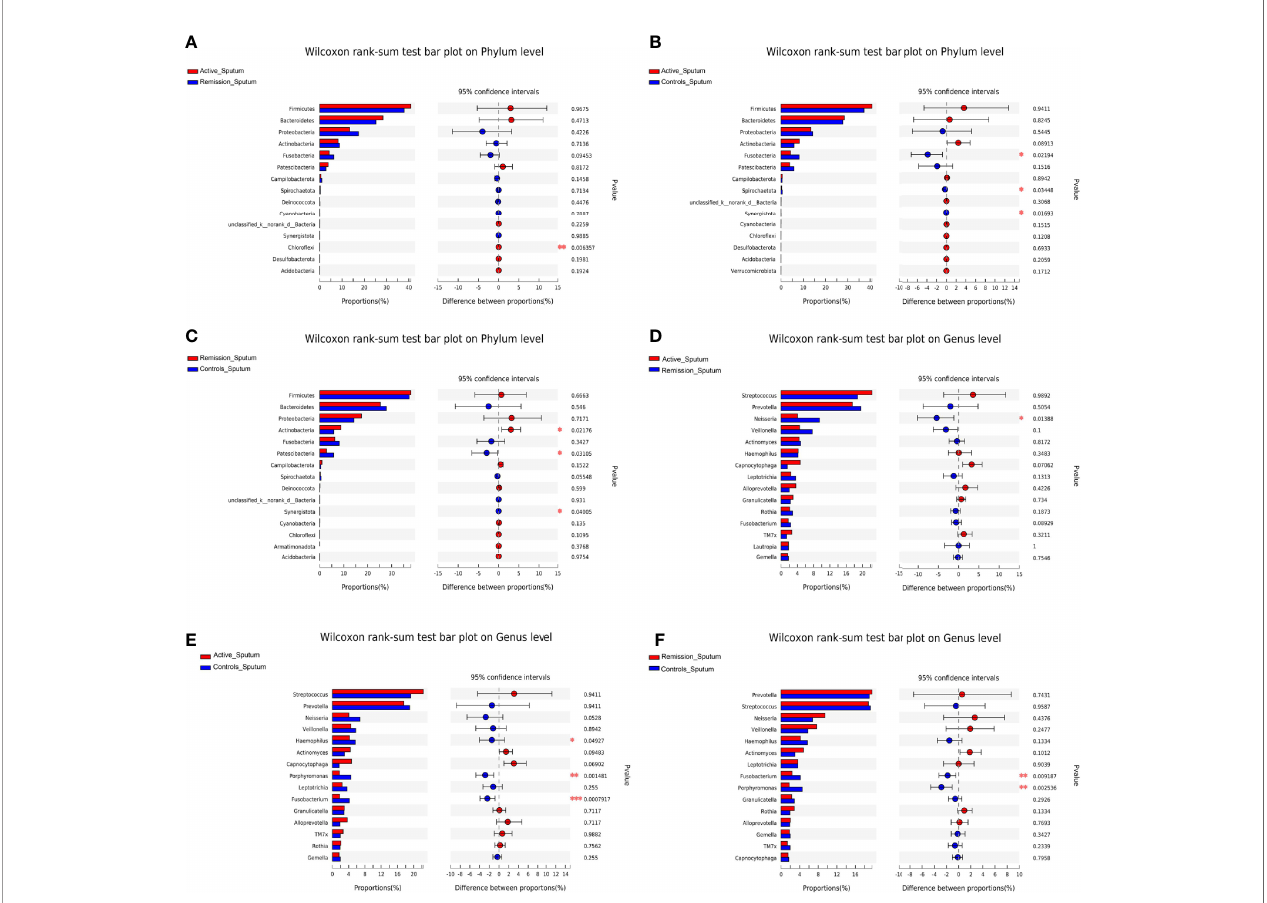
FIGURE 6 | Inter-group difference analysis of sputum microbiota of patients with CD and healthy controls. (A – C) Wilcoxon rank-sum test bar plot of different taxa on the phylum level. (D – F) Wilcoxon rank-sum test bar plot of different taxa on the genus level. *, **, and *** correspond to p-values <0.05, 0.01, and 0.001,